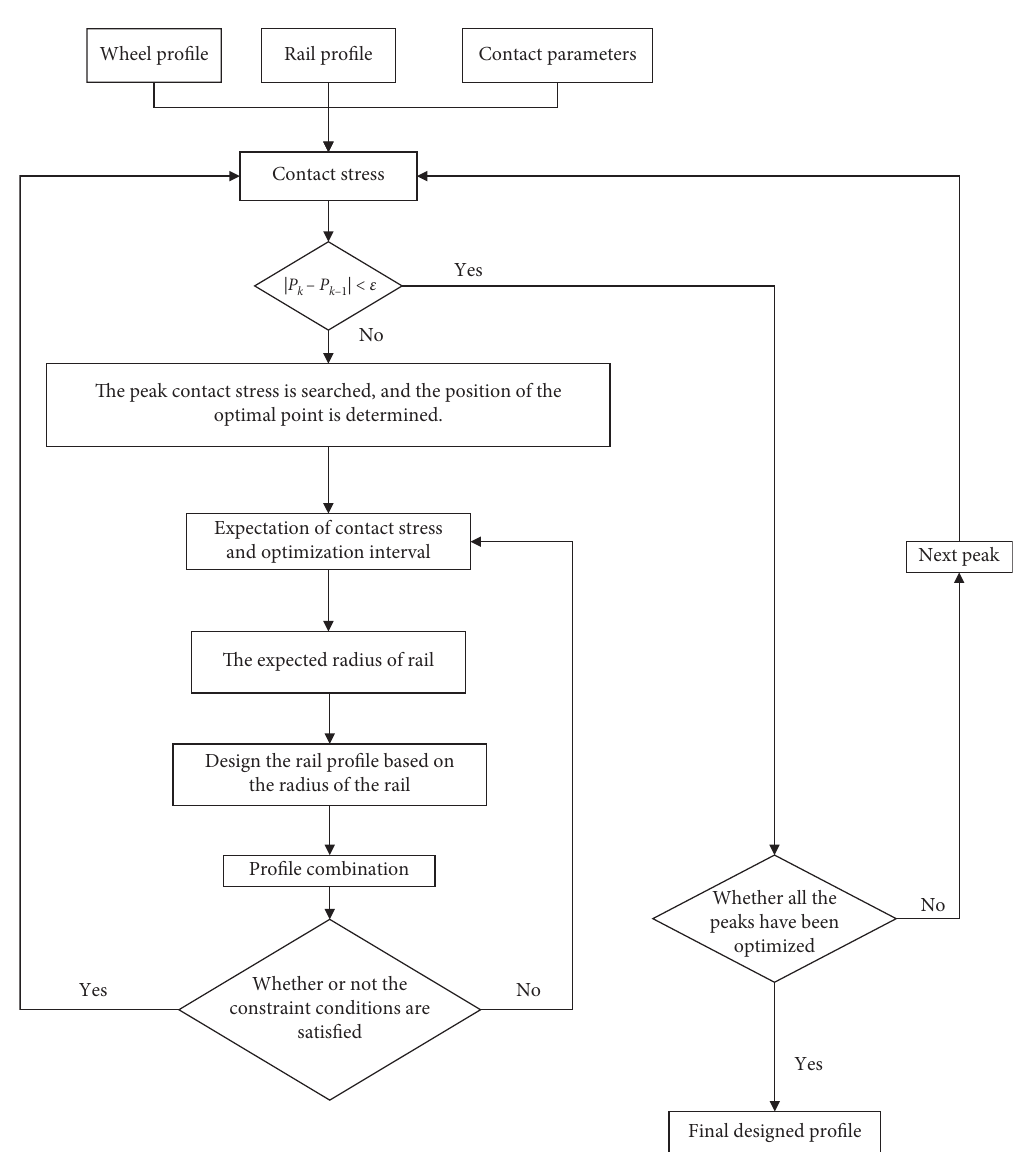
Figure 9: Flowchart of the rail profile